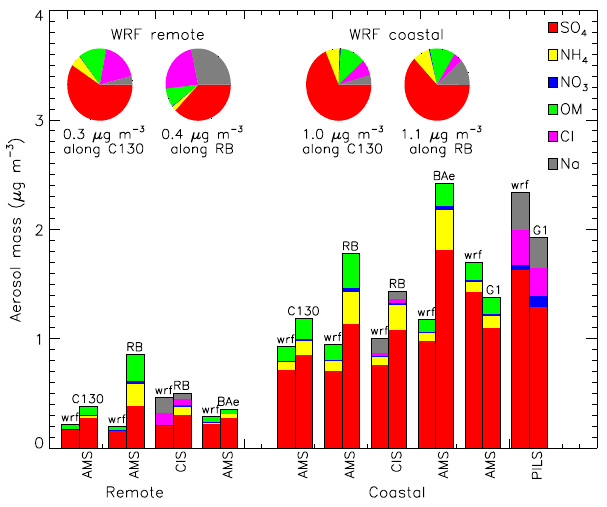
Fig. 5. MBL submicron aerosol mass composition from VOCALS- REx measurements and from the AERO simulation. The measure- ments are provided by AMS instruments onboard the C-130, RB, and G-1 and those sampled by the CIS and a PILS onboard the RB and G-1, respectively. The pie charts and the total aerosol mass provided below them are based on the AERO simulation; only data along C-130 and RB tracks at the sampling time are included into the calculations. The dividing longitude for the coastal and remote regions is 78 ◦ W, and the BAe-146 measurement data only covered the east edge of the remote region (78–81 ◦ W with a mean longitude of 79 ◦ W).